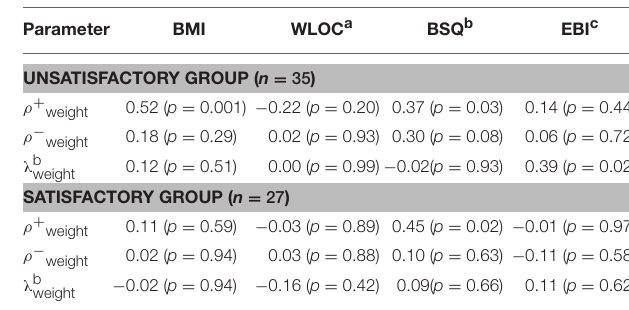
TABLE 2 | Pearson correlations between prospect theory risk-seeking and weight-loss aversion parameters and self-report scales in unsatisfactory and satisfactory